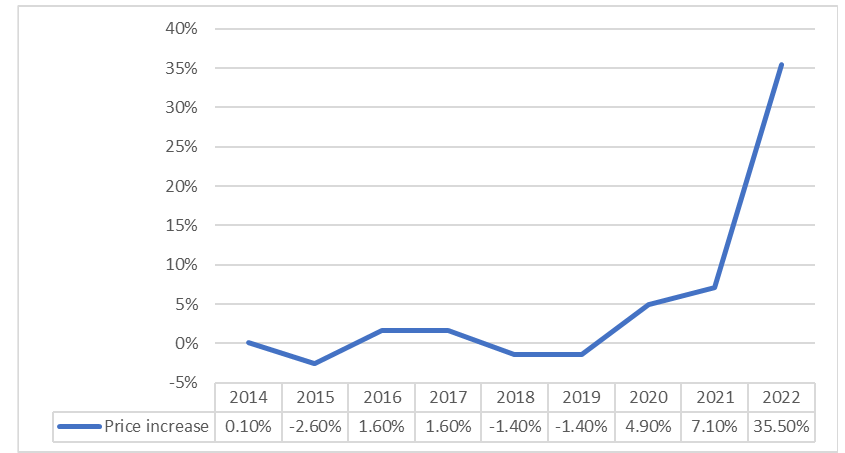
Figure 1. Increase in energy prices in Poland (2014 – 2022) [30].